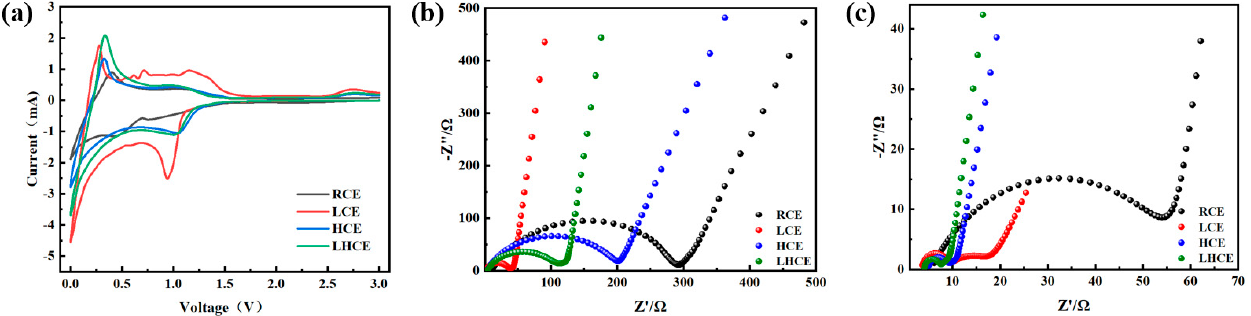
Figure 2. CV of Li||C batteries in ( a ) RCE, ( b ) LCE, ( c ) HCE, ( d ) LHCE.